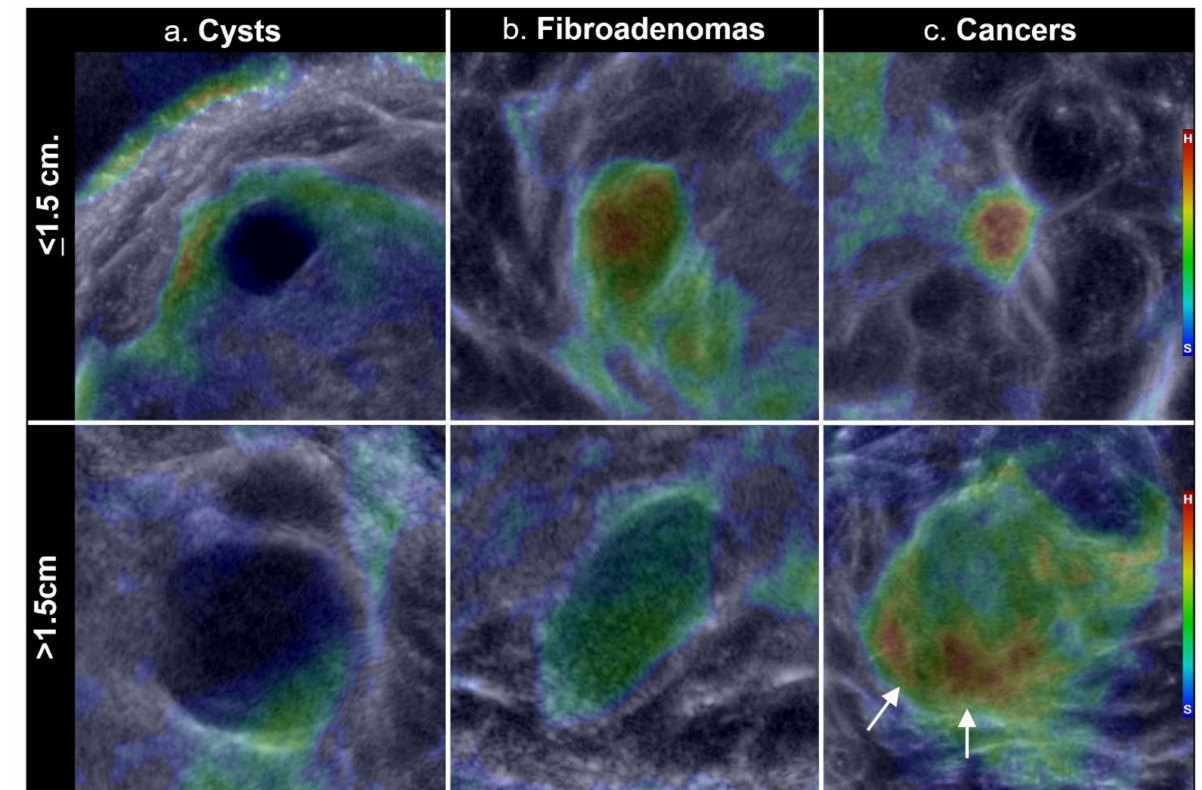
Figure 6. ( a – c )–Filtered stiffness images in columns of cysts ( a ), fibroadenomas ( b ), and cancers ( c ), shown cropped to scale, with the top row showing masses ≤ 1.5 cm while the bottom row shows comparable type masses >1.5 cm. Note the more blended appearance of a small stiff fibroadenoma ( b ), compared with the more centrally dominant stiffness of a small cancer. The larger invasive ductal carcinoma (C bottom row) was overall softer but had a relatively hard inferior margin (arrows in ( c ), bottom